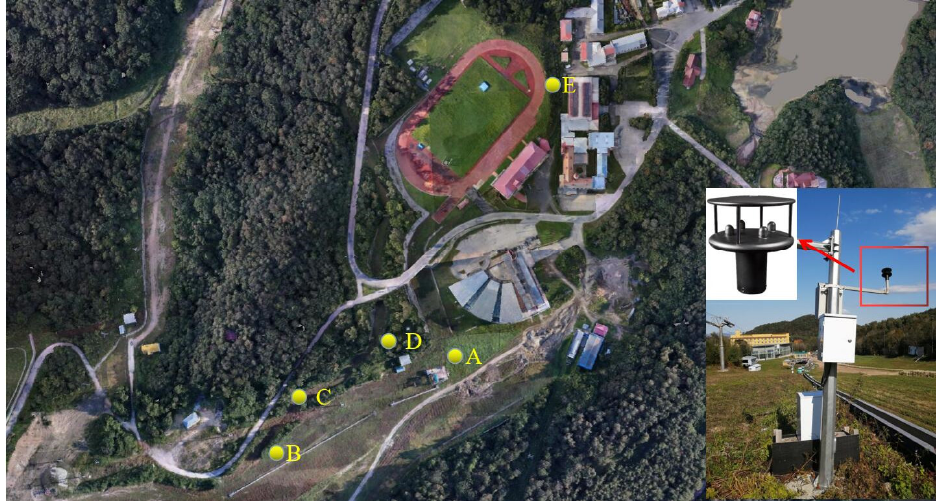
Figure 13. Field anemometer deployment. A–E are the deployment positions of the anemometer